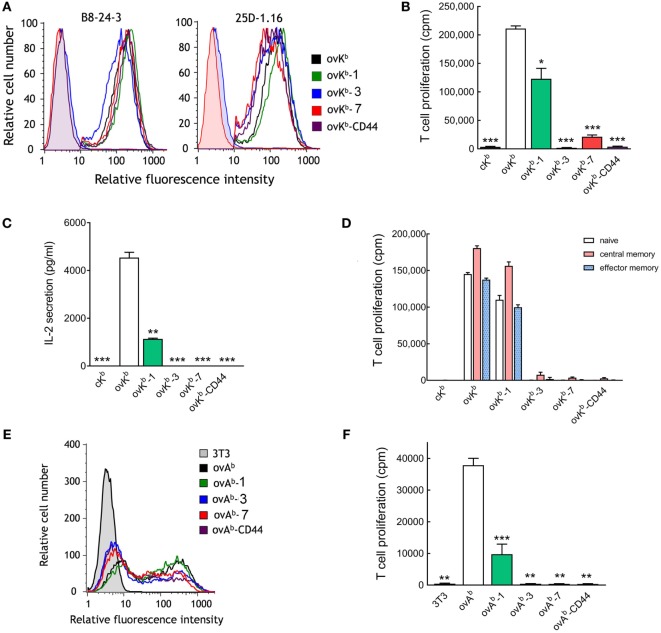
Effect of single-chain peptide/MHC on T cell activation. (A) 3T3 antigen-presenting cells (APCs) that stably express single-chain ovKb molecules with different tethers were immunofluorescence stained for H-2Kb (PE-labeled AF6-88.5), SIINFEKL presented by H-2Kb (25D-1.16) or isotype controls (shaded curves) and analyzed on a flow cytometer. 3H-thymidine incorporation (B) and IL-2 secretion (C) in 2 × 105 CD8+ T cells from OT-I mice incubated with 2 × 104 ovKb APCs for 48 h (n = 3). A single-chain MHC molecule (cKb) that presents the HPV 16 E748–55 peptide was also expressed on 3T3 cells as a negative control. Bars, SD. Significant differences between ovKb and other membrane-tethered ovKb molecules are indicated: *p < 0.05, **p < 0.005, ***p < 0.0005. (D) The potency of ovKb APCs to activate naïve, central memory, or effector memory OT-I T cells. (E) 3T3 APCs transiently expressing MHC class II single-chain ovAb molecules were immunofluorescence stained with anti-FLAG M2 antibody and analyzed on a flow cytometer. (F)
3H-thymidine incorporation in 2 × 105 OT-II CD4+ T cells stimulated with 2 × 104 unmodified 3T3 cells or ovAb APCs for 48 h (n = 3). Bars, SD. Significant differences between ovAb and other membrane-tethered ovKb molecules are indicated: **p < 0.005; ***p < 0.0005.